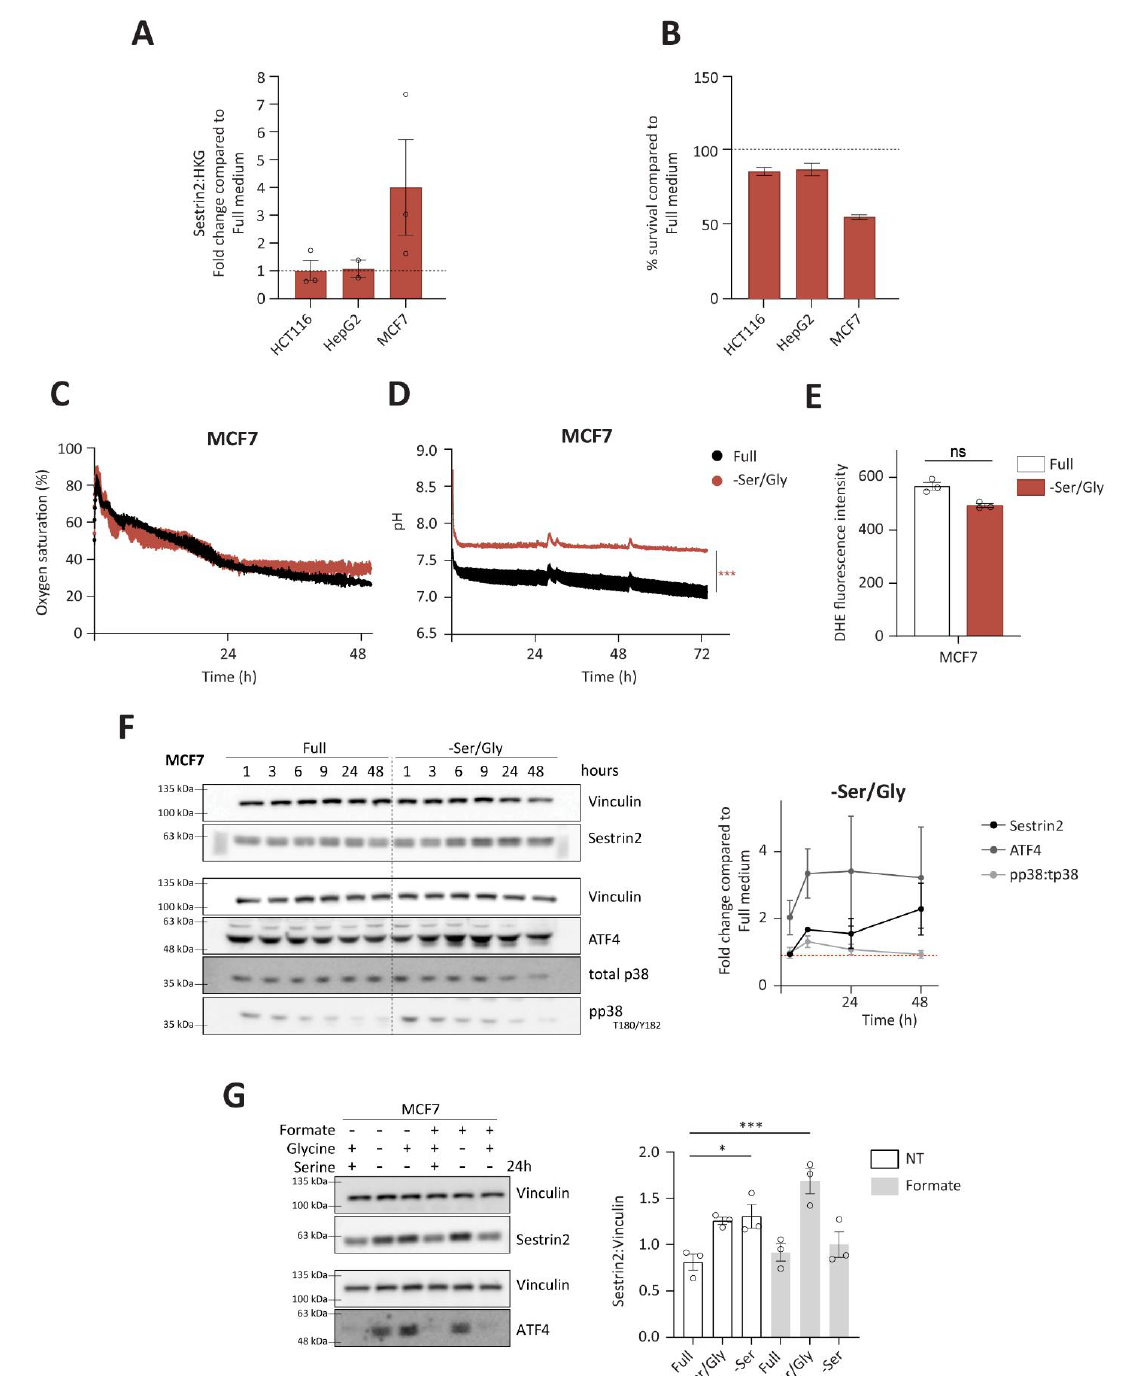
Figure 4. Group 2 of amino acid deprivations causes solely nutritional stress. ( A ) Quantification of Sestrin2 protein levels upon 2 days of serine and glycine deprivation (n = 3); ( B ) cell survival upon 3 days of serine and glycine deprivation; ( C , D ) continuous measurements of oxygen saturation ( C ) and pH ( D ) values in extracellular medium; ( E ) mitochondrial membrane potential measured 24 h of amino acid deprivations; ( F ) timedependent regulation of Sestrin2, ATF4, and phosphorylation of p38 upon the deprivation with respective densitometric quantification (n = 2–3); ( G ) Sestrin2 and ATF4 levels in the presence or absence of either serine (0.4 mM), glycine (0.4 mM), sodium formate (1 mM), or in combination, with the densitometric quantification of Sestrin2 (n = 3). One-way ANOVA with the Dunnett’s post hoc test was for statistical analysis. Dots represent individual values. * and *** indicate p ≤ 0.05, and 0.001, respectively. n.s. indicates statistical